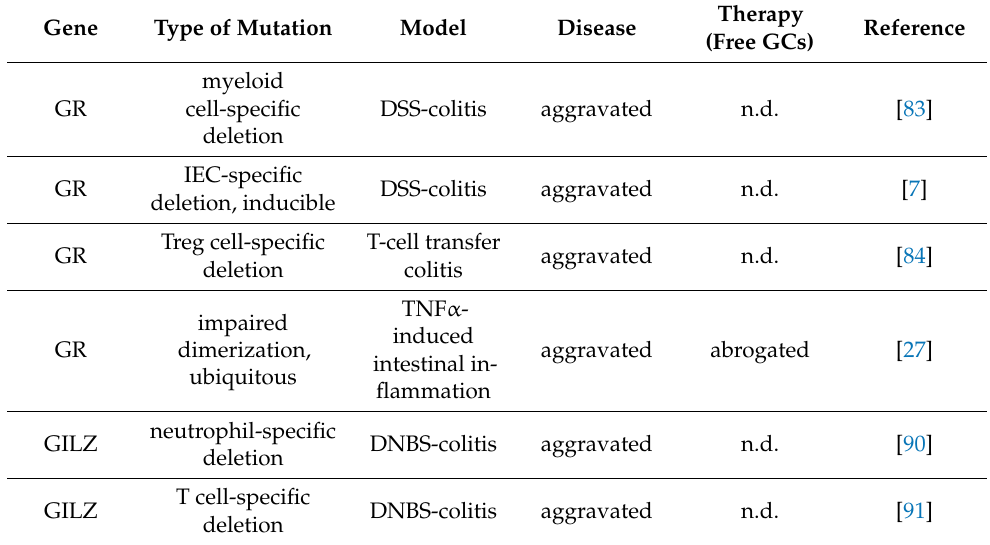
Table 2. Phenotype of selected genetic mouse models of IBD. n.d.: not determined.